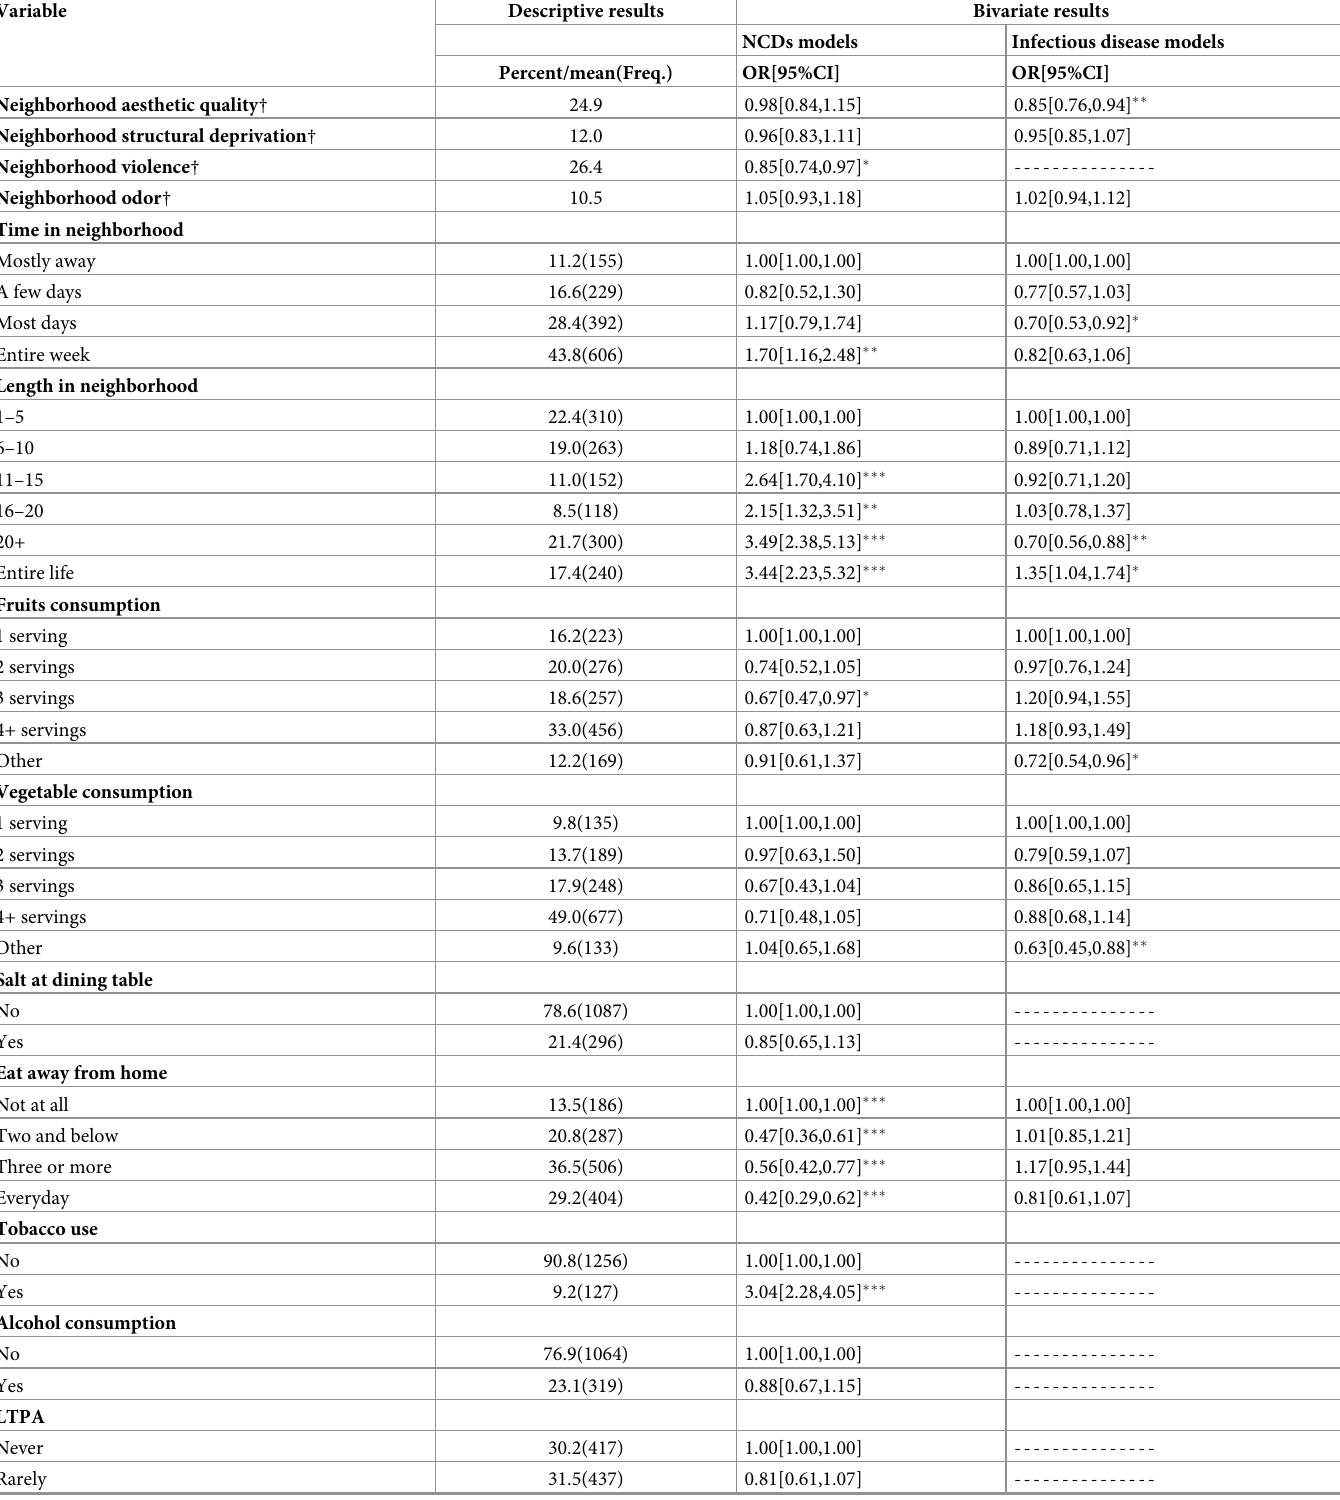
Table 1. Descriptive statistics and bivariate results of the relationship between the dependent and independent